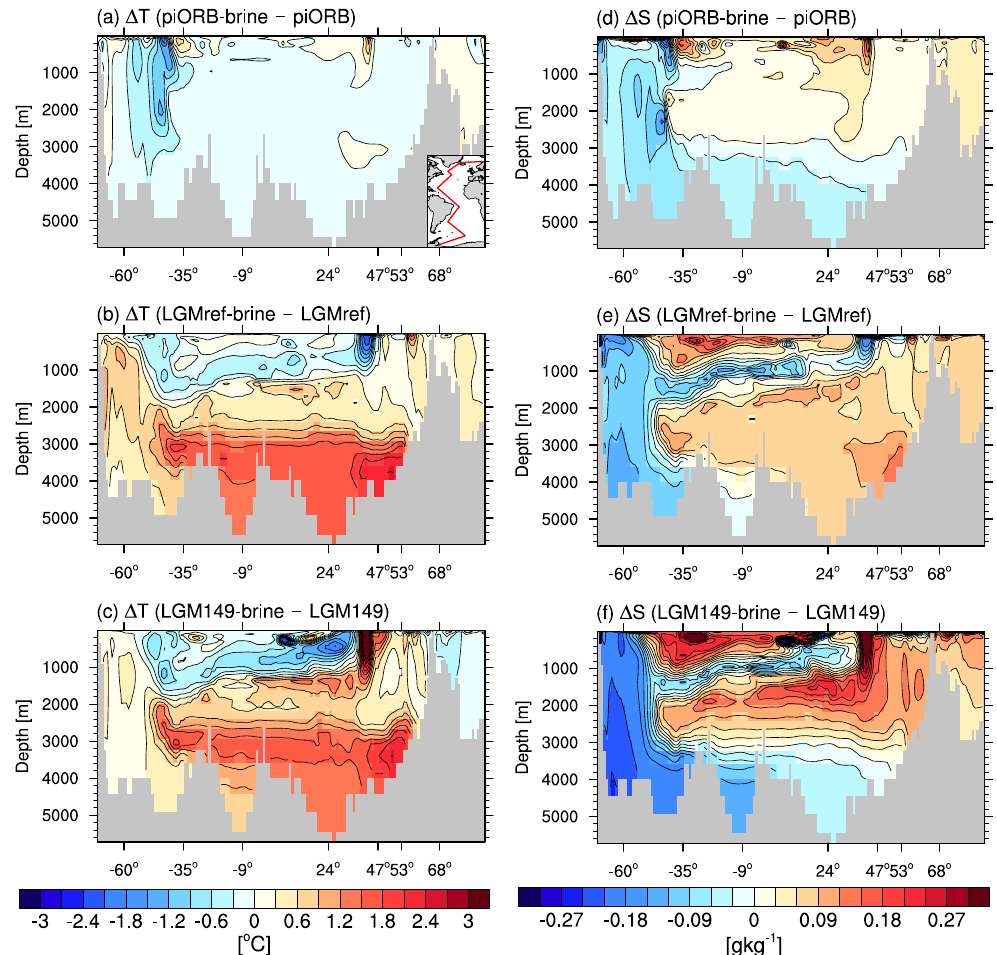
Figure 13. Temperature and salinity changes caused by the reduced brine release. Shown is the same transect through the Atlantic as in Fig. 5. Temperature difference for (a) piORB-brine – piORB, (b) LGMref-brine – LGMref and (c) LGM149-brine – LGM149. Salinity difference for (d) piORB-brine – piORB, (e) LGMref-brine – LGMref and (f) LGM149-brine – LGM149. Contour intervals are 0.3 ◦ C and 0.03gkg − 1 ,